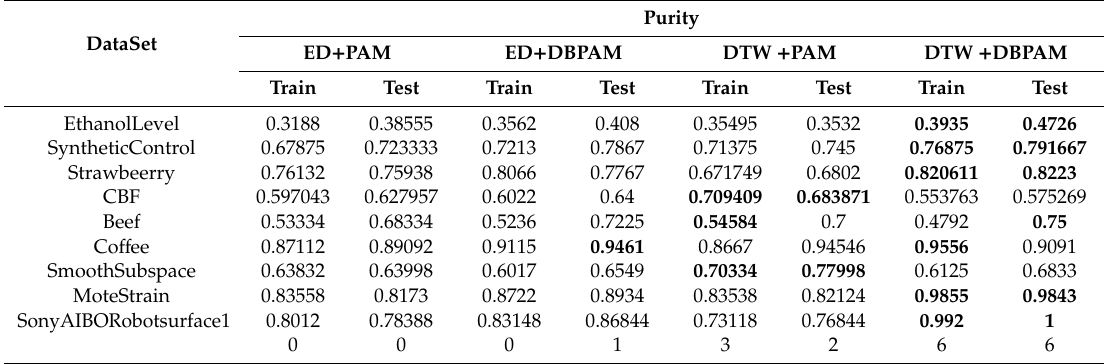
Table 2. Results of 4 methods on 9 datasets.